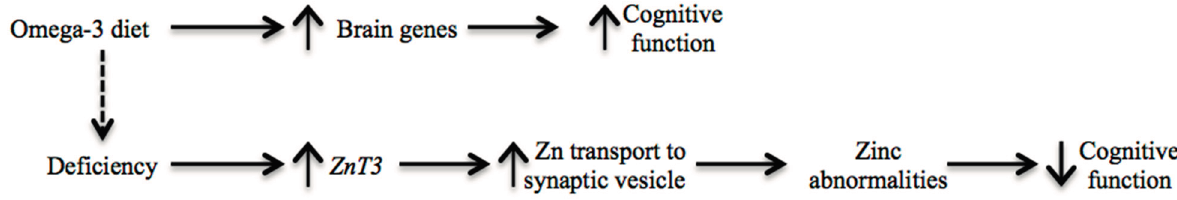
Figure 2. The potential molecular mechanism by which omega-3 fatty acid may interact with the zinc transporter in brain cognitive